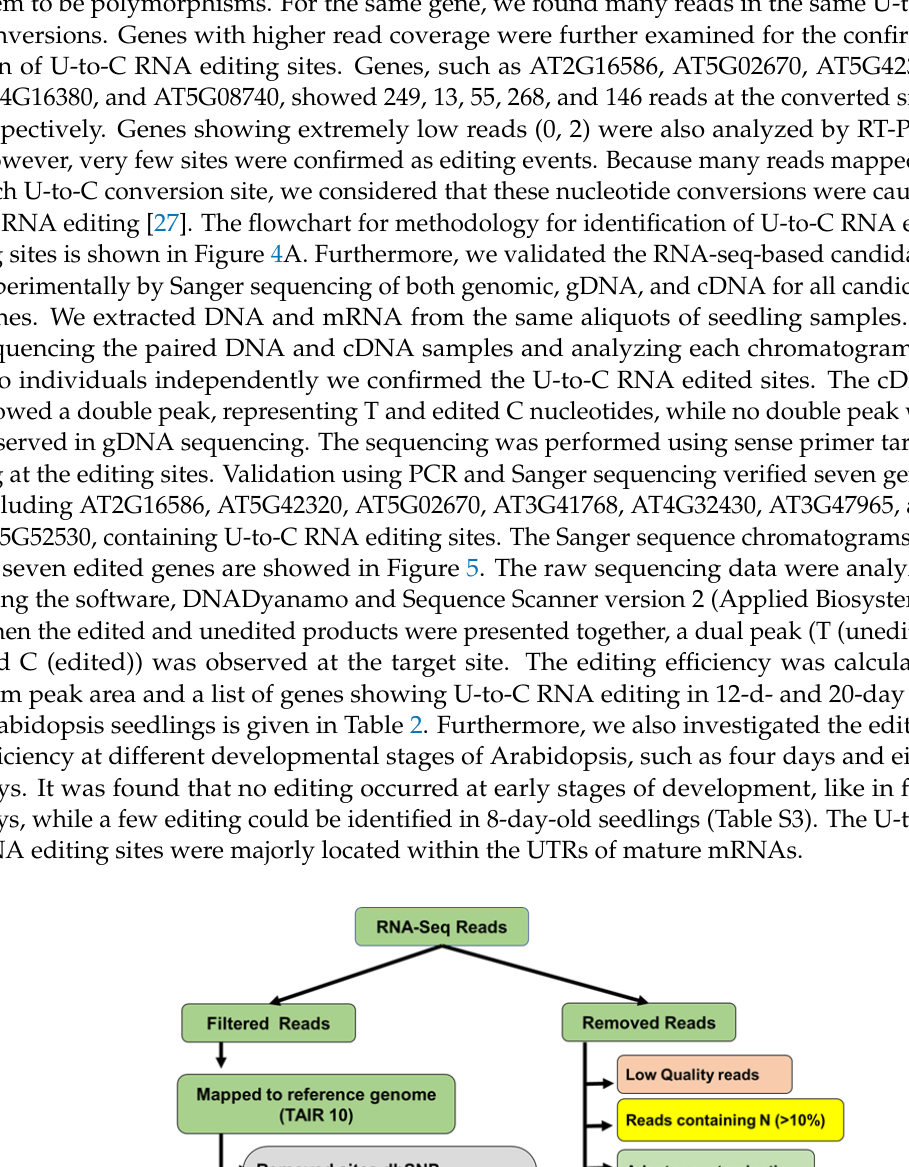
Figure 4. The flowchart for methodology for identification of U-to-C RNA editing site. ( A ) Raw reads are filtered to remove reads containing adapters or reads of low quality, so that downstream